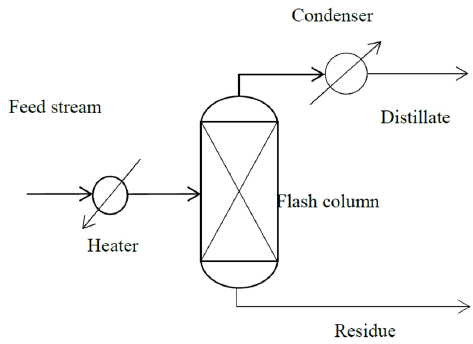
Figure 3. Refined palm oil deodorization process.